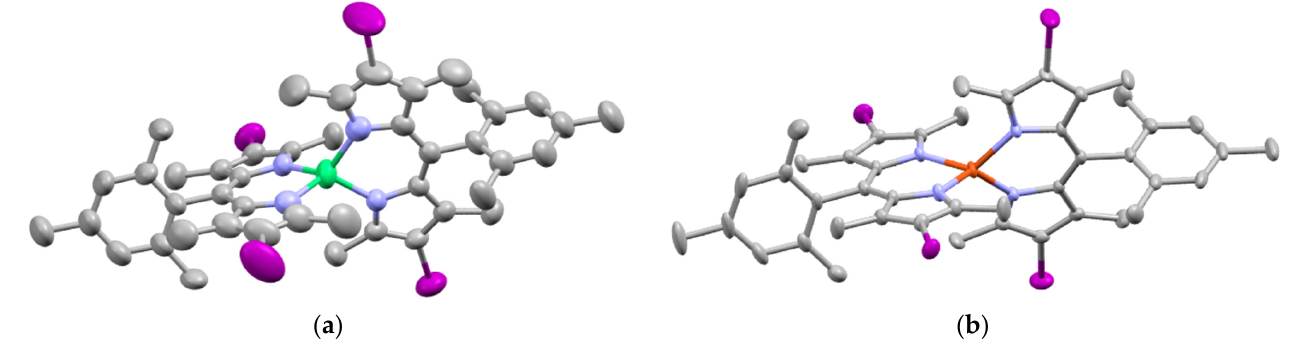
Figure 25. Molecular structures of ( a ) Ni-3 and ( b ) Cu-4 in the crystal. Hydrogen atoms have been omitted for clarity, thermal ellipsoids show 50% probability [15]. See the main text for more discussion on the properties of these compounds. (CCDC number: ( a ) 1976221 and ( b ) 1976222 [183]).